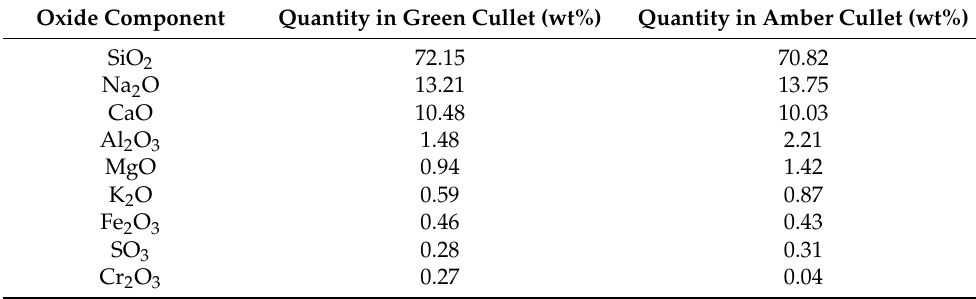
Table 1. Oxide compositions of waste green and amber container